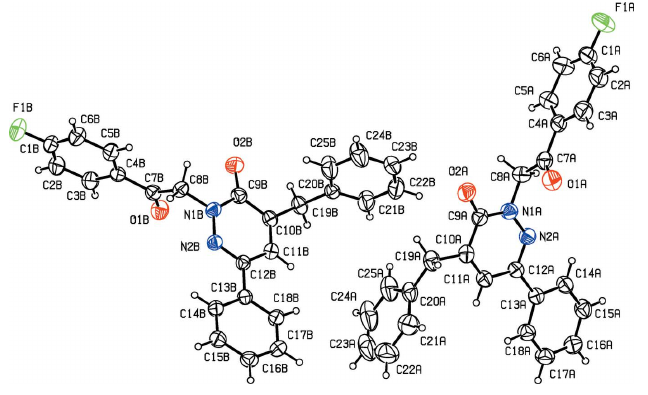
Figure 1 The molecular structure of the title compound, with the atom labelling and displacement ellipsoids drawn at the 30% probability